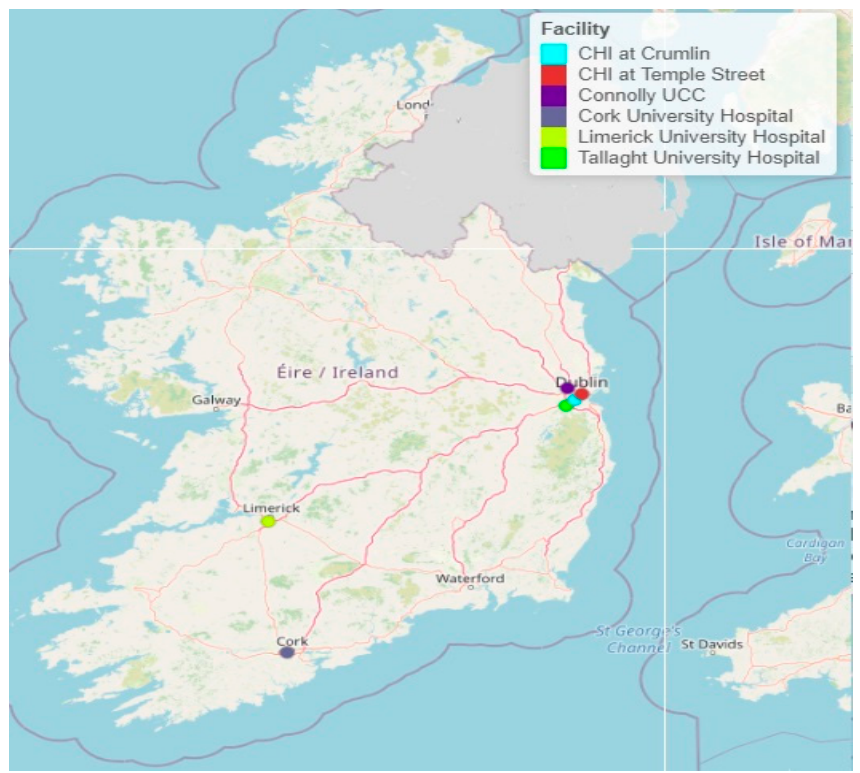
Figure A1. Location of participating sites.